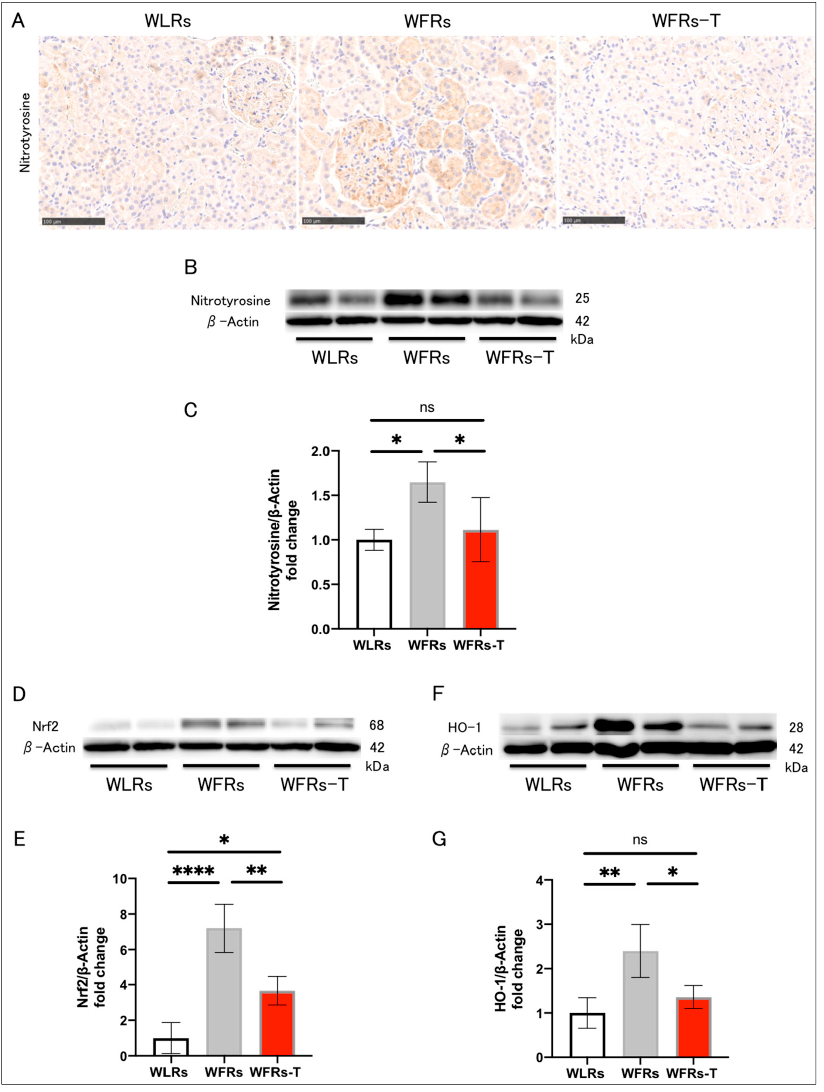
Figure 4. Changes in renal oxidative stress: ( A ) representative images of nitrotyrosine immunohisto- chemistry (scale bar: 250 μ m); ( B ) representative immunoblots of nitrotyrosine and β -actin; ( C ) the quantitative ratios of nitrotyrosine to β -actin in the renal cortex ( n = 4); ( D ) representative immunoblots of nuclear factor-erythroid 2-related factor 2 (Nrf2) and β -actin; ( E ) the quantitative ratios of Nrf2 to β -actin in the renal cortex ( n = 4); ( F ) representative immunoblots of heme oxygenase 1 (HO-1) and β -actin; and ( G ) the quantitative ratios of HO-1 to β -actin in the renal cortex ( n = 4). All data are means ± standard deviation (SD). * p < 0.05, ** p < 0.01, **** p < 0.0001, ns: not significant. WLRs, sedentary Wistar lean rats; WFRs, sedentary Wistar fatty rats; WFRs-T, Wistar fatty rats with treadmill exercise